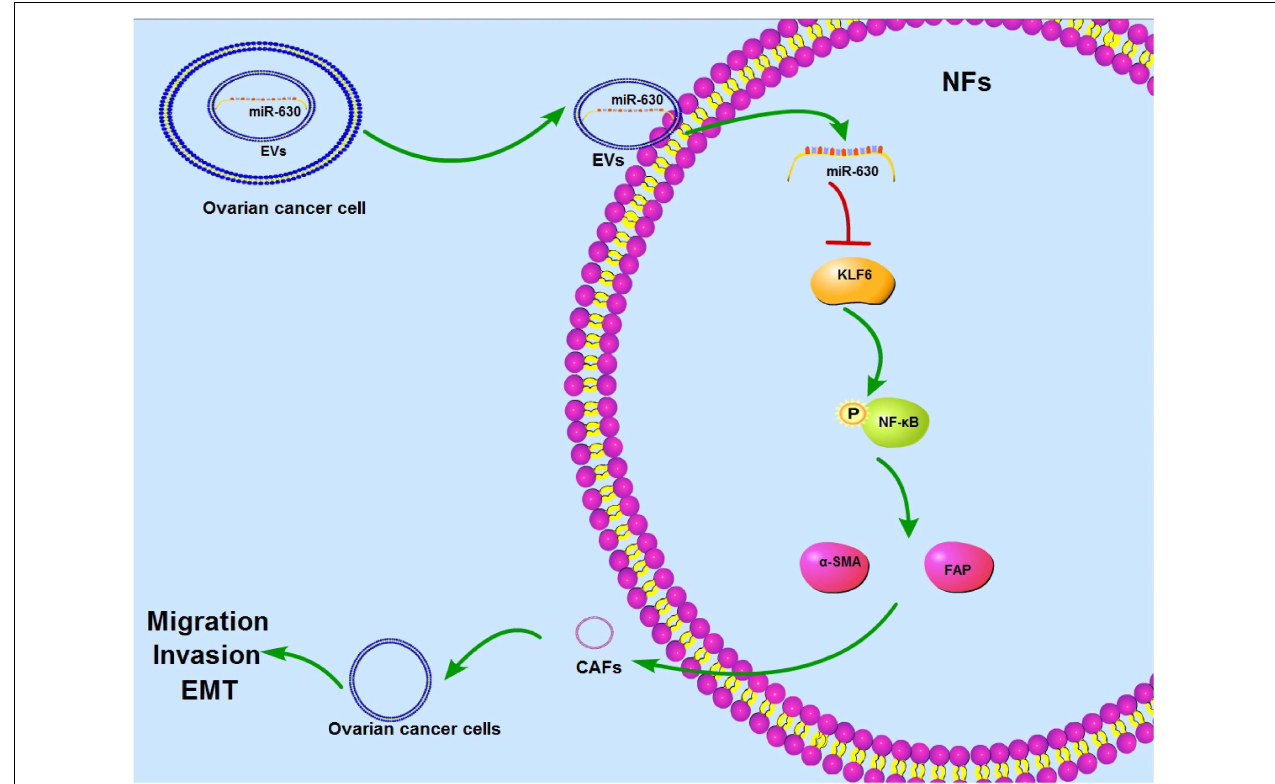
FIGURE 10 | Mechanism diagram. EVs activated CAFs and promoted invasion and metastasis of OC cells via the miR-630/KLF6 axis. OC cells-derived EVs could be internalized by NFs, so miR-630 carried by EVs could enter into NFs to promote activation of CAFs and facilitate invasion and metastasis of OC by targeting KLF6 and activating the NF- κ B